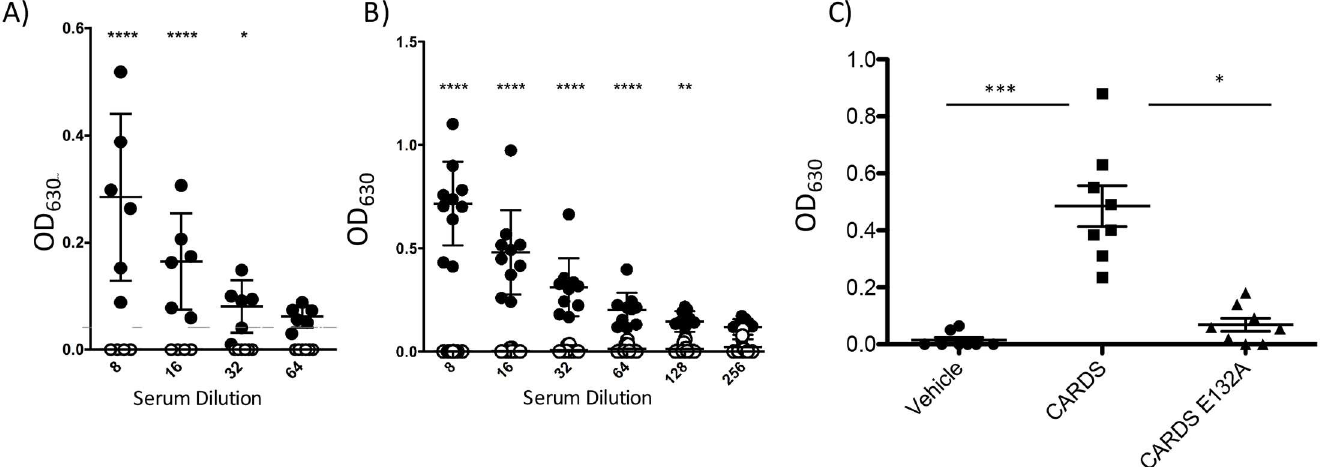
Fig 4. Exposure to active CARDS toxin results in CARDS toxin-specific IgE. A) Mice were exposedto a single dose of CARDS toxin IT and then serum collectedon day 56. The indicateddilution of serum was tested for CARDS toxin-specific IgE in a sandwich ELISA. B) Mice were exposedto 700 pmol of CARDS toxin on days 0 and 21 IT and serum was collectedon day seven after the second exposure. C) Mice were exposedto wild type or mutant CARDS toxin on days 0 and 21 and serum collectedon day 28. ( * p = 0.05, ** p < 0.005, **** p < 0.0005 N = 6–10 mice/time